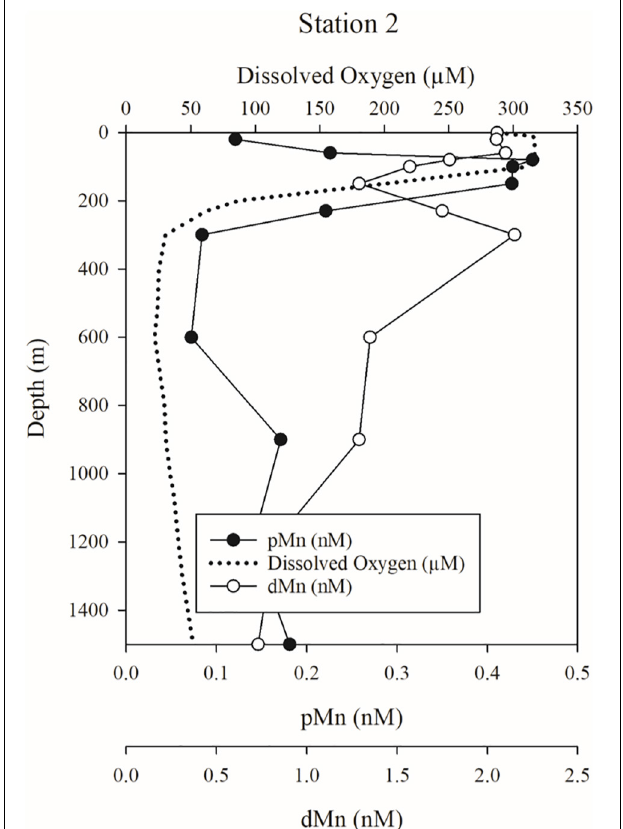
FIGURE 9 | Dissolved (dMn) and particulate Mn (pMn) profiles with dissolved oxygen concentrations at station